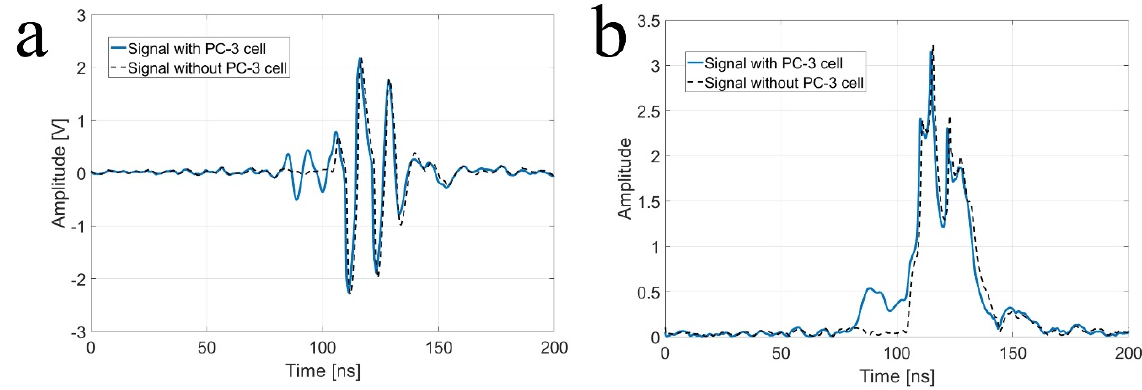
Figure 6. B-mode imaging of a PC-3 cell with a 110 MHz transducer.